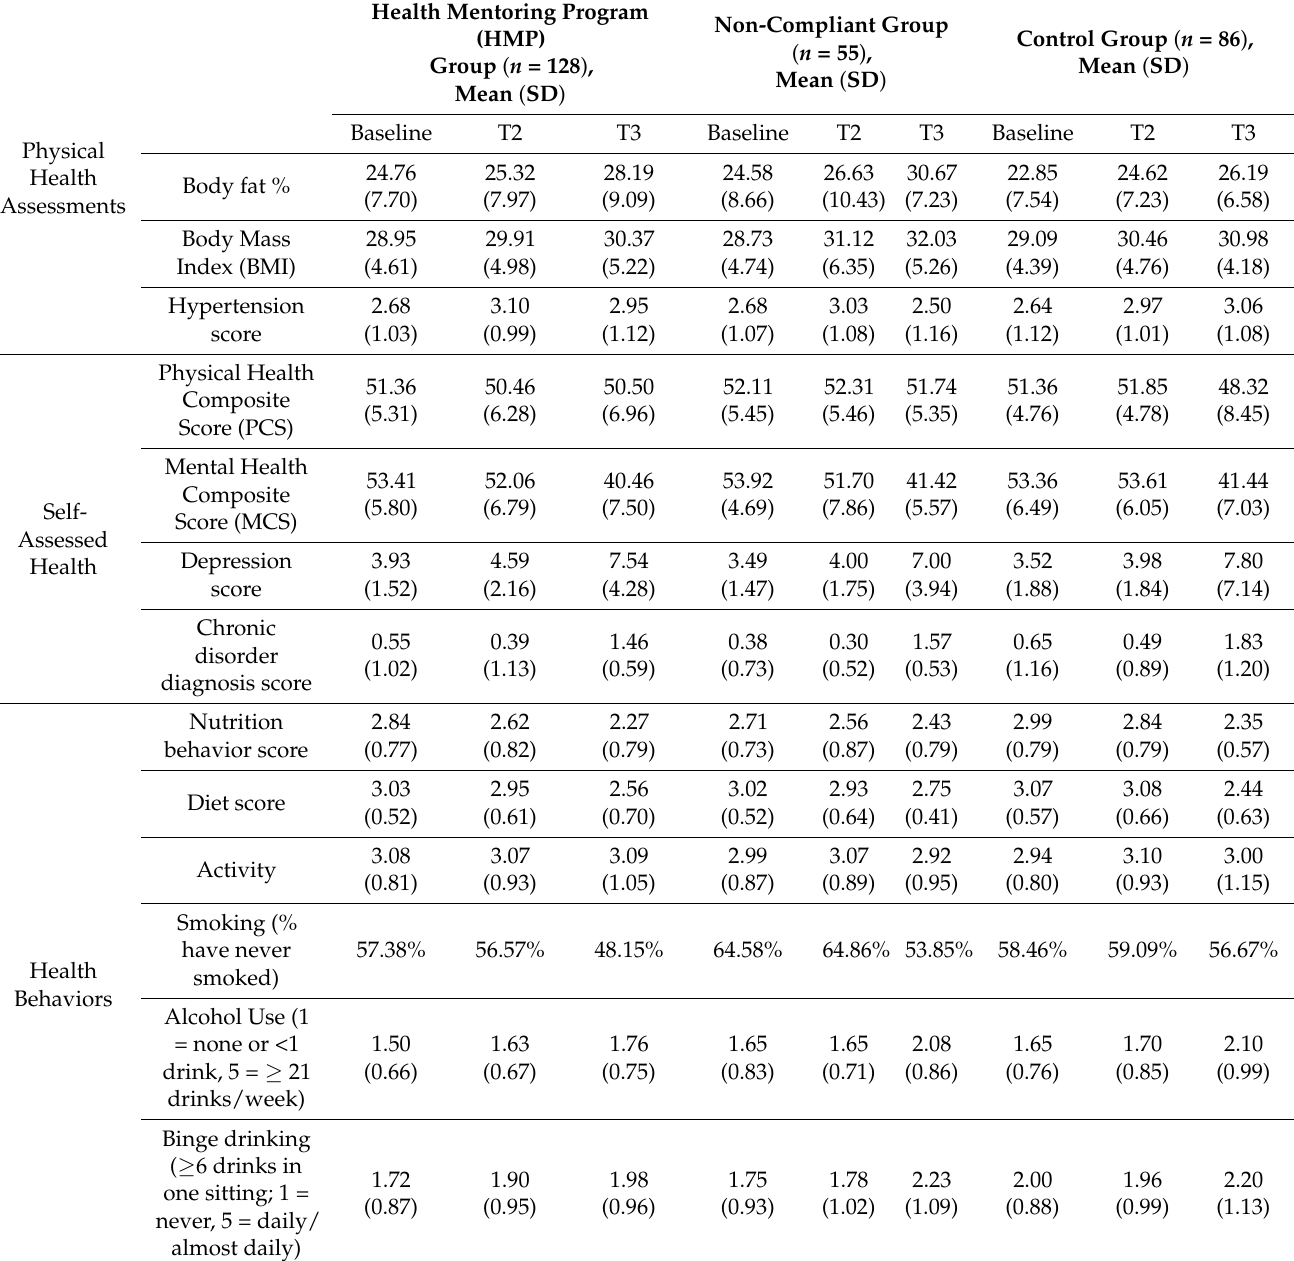
Table 2. Comparison of physical health assessments, and self-assessed health outcomes among study groups in all 3 time